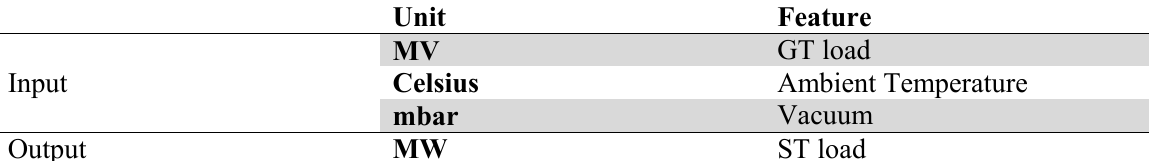
Steam Turbine data structure